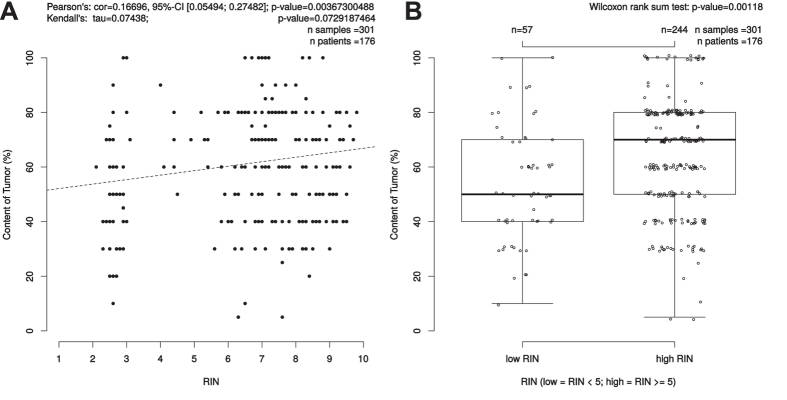
Correlation between content of tumor (%) and RIN.(A) Scatterplot: Pearson’s correlation coefficient (r) and due to skewedness of the data also Kendall’s rank correlation tau were depicted as measures. Kendall’s rank correlation yielded a tau of 0.0743838 and had a p-value of 0.07292. (B) The bimodal distribution of RIN values was the trigger to further investigate the Wilcoxon test results for the low/high RIN classes, which result here in a p-value of 0.00118.